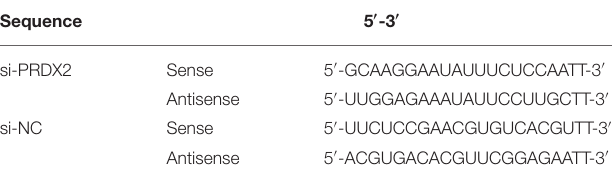
TABLE 1 | Sequences of transfection.